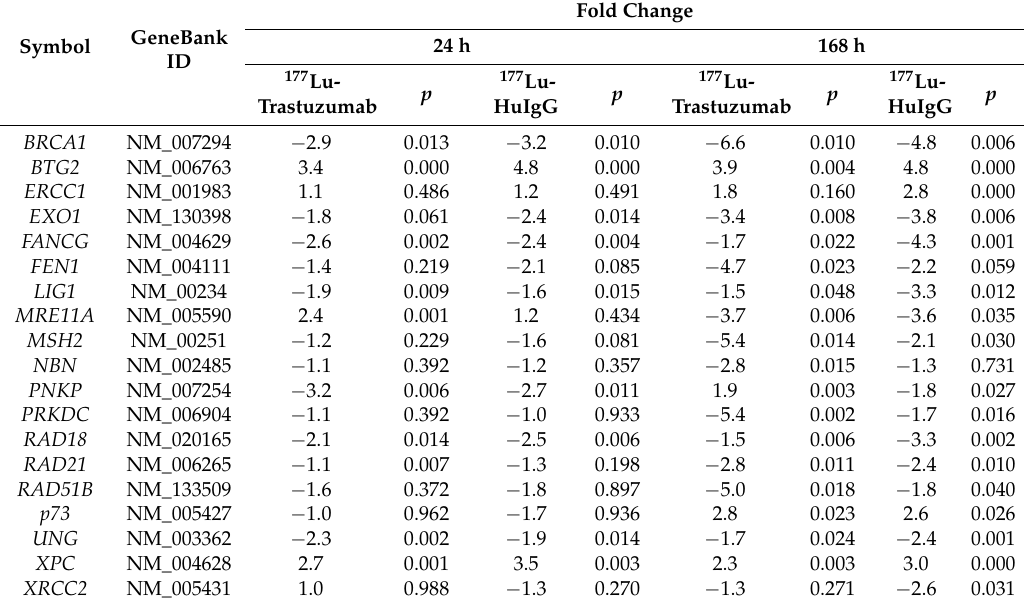
Table 4. Expression of genes involved in DNA damage repair in LS-174T i.p. xenografts following treatment with 177